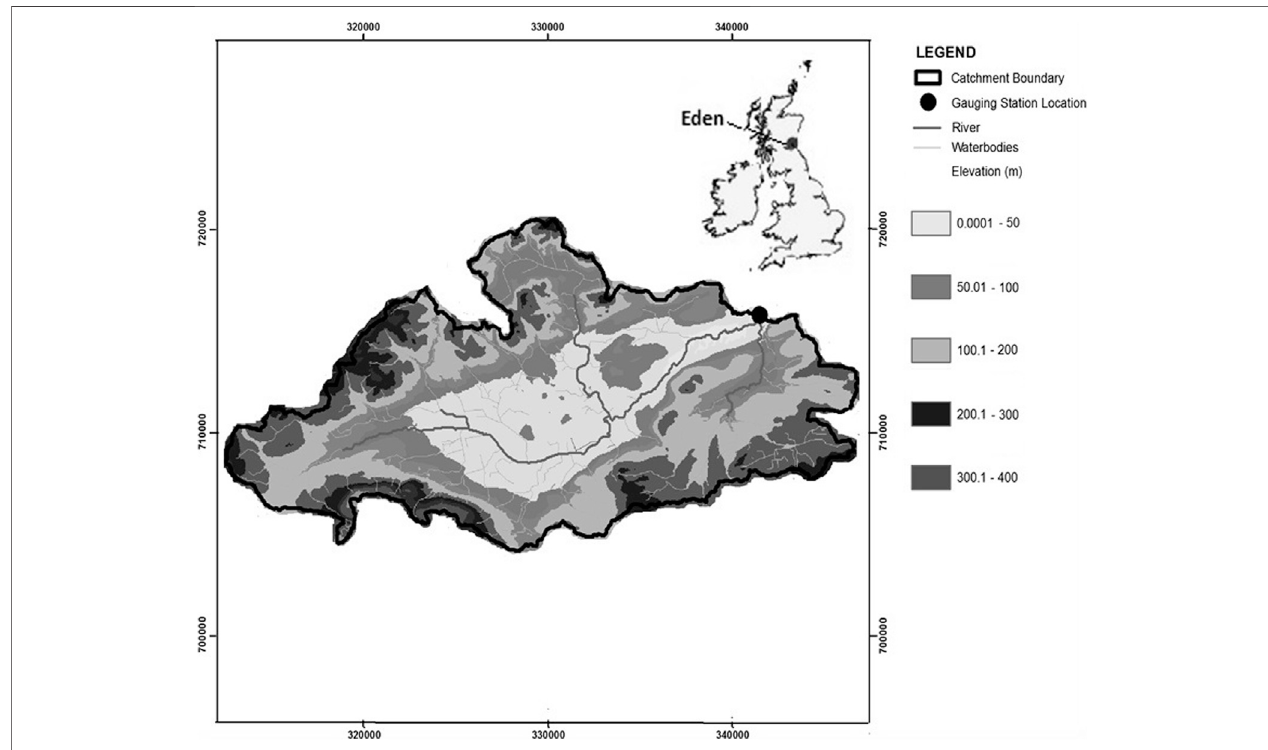
FIGURE1| Catchmentlocation,streamroute,gaugingstationposition,andelevation.Source:catchmentboundaries(Morrisetal.,1990;MorrisandFlavin,1994). Elevation data courtesy of Intermap Technologies Inc. (Nextmap 50 m Digital Terrain Model).